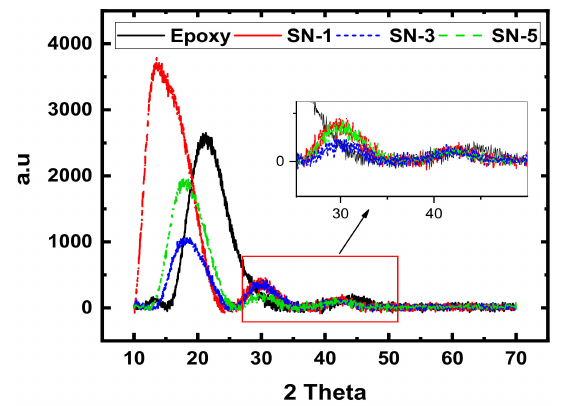
Figure 3. XRD patterns obtained for the silica incorporated epoxy (SN1, SN3, and SN5)